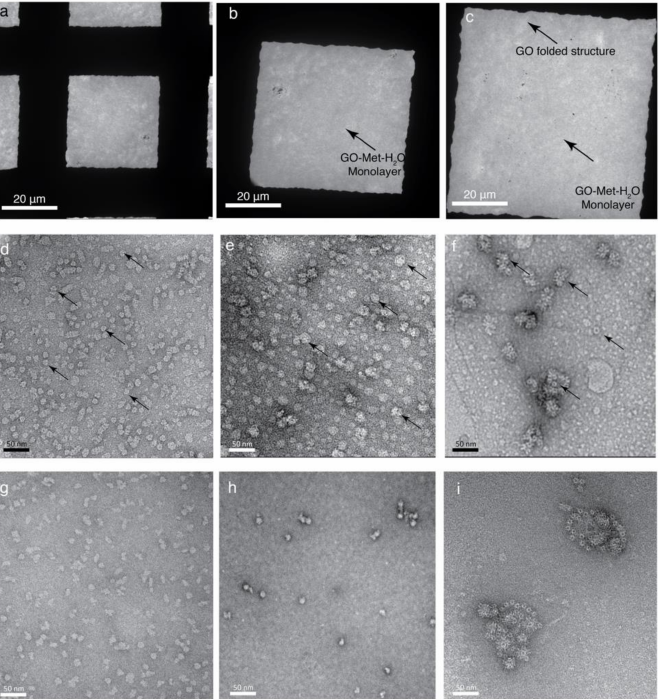
Figure 3. Monolayer GO supported TEM grids for negative staining imaging: ( a ) TEM image shows that the entire grid square is covered with a fine monolayer of GO. ( b , c ) Magnified view of each grid square. Arrows point at the near-transparent GO monolayer. A folded structure has been marked to represent complete coverage of the square. ( d – f ) Dispersion of various protein samples on GO fabricated TEM grids, observed at 80 K magnification. Arrowheads indicate each protein particle–MdtB ( d ), E. coli 70S Ribosome ( e ), VCC ( f ). ( g – i ) shows the same sample on carbon coated TEM grids (as control). ( g ) MdtB ( h ) E. coli 70S Ribosome and ( i ) VCC on carbon. GO coated TEM grids ( d – f ) attracts more biological